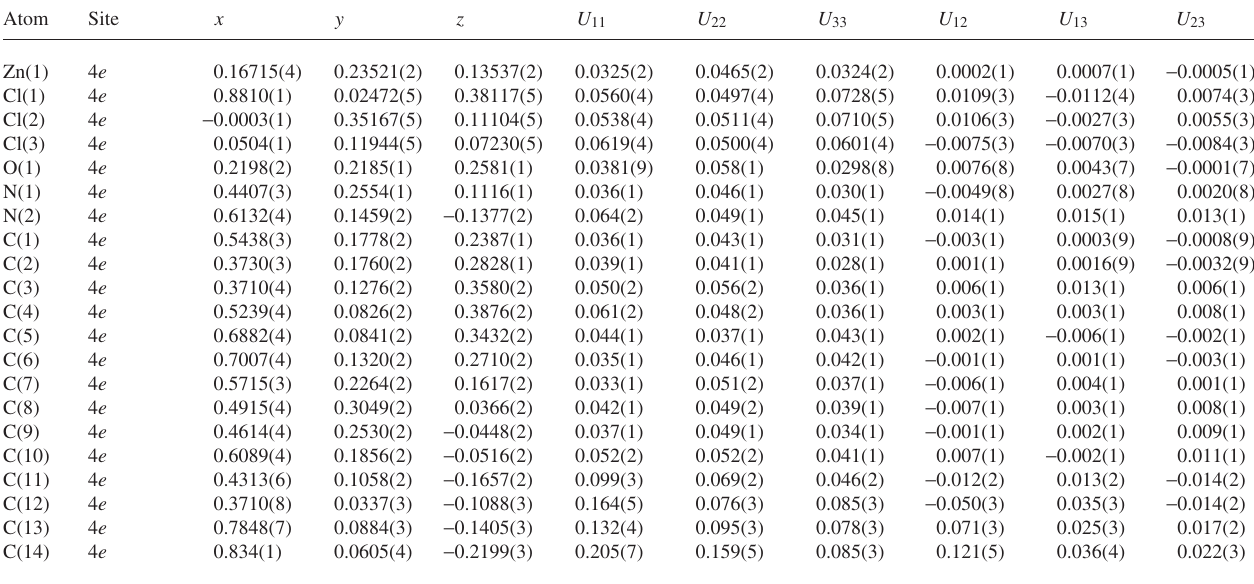
Table 3. Atomic coordinates and displacement parameters (in Å 2 )